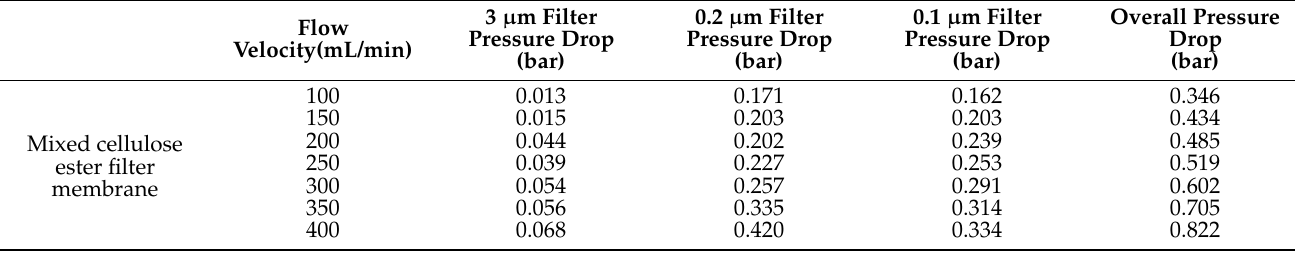
Table 3. Flow velocity–pressure drop of four kinds of filter